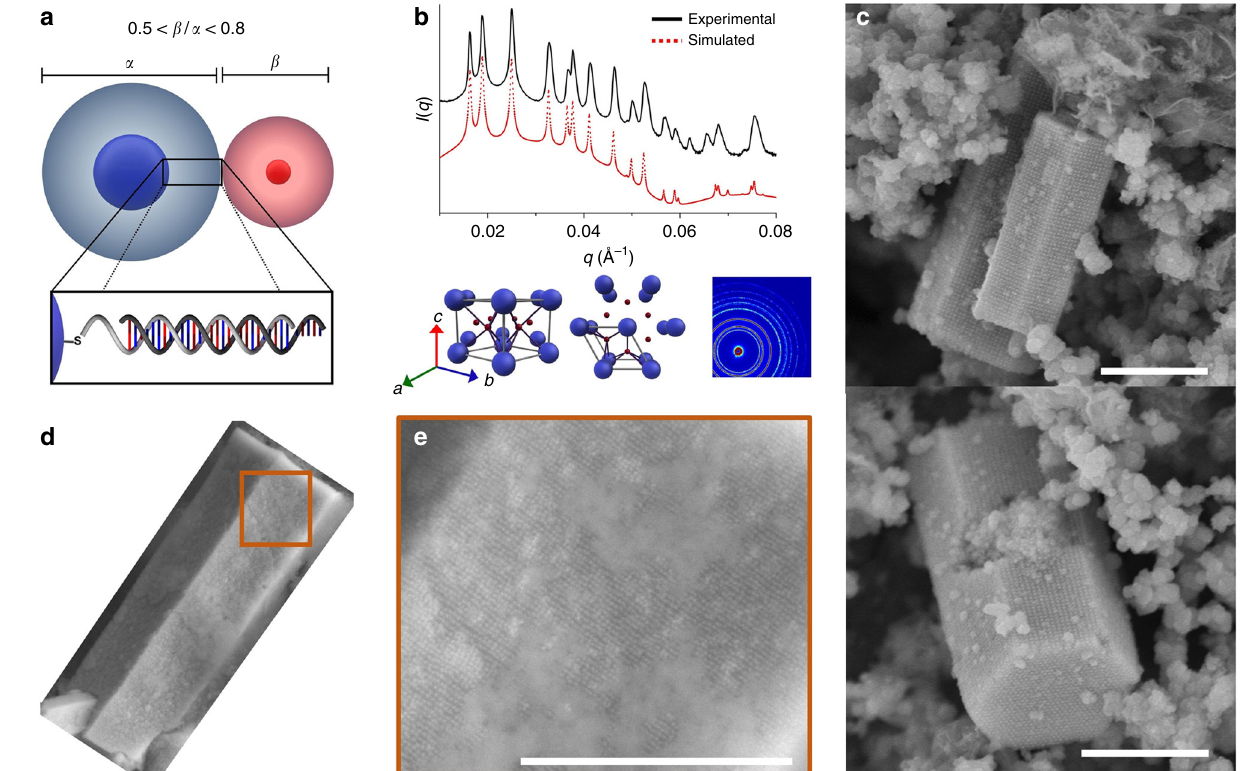
Fig. 1 Hexagonal prism microcrystals formed from DNA-functionalized nanoparticles. a Scheme of a set of DNA-functionalized gold nanoparticles with a hydrodynamic radius ratio ( β / α ) between 0.5 and 0.8 used to produce superlattices with AB 2 crystallographic symmetry. α and β denote hydrodynamic radii of particles A and B. b Representative one-dimensional (top) and two-dimensional (bottom, right) SAXS data for AB 2 superlattices assembled from the slow cooling approach. Different views of the AB 2 unit cell (bottom, left) are shown for reference. SAXS data are shown as plots of the overall scattering intensity from a crystal domain ( I(q) , in arbitrary units) versus scattering vector ( q , in units of Å − 1 ). c SEM images of hexagonal prism microcrystals in different orientations. d , e SEM images of a representative microcrystal with visible faceting ( d ) where constituent nanoparticles can be seen ( e ). Scale bars are 1 μ